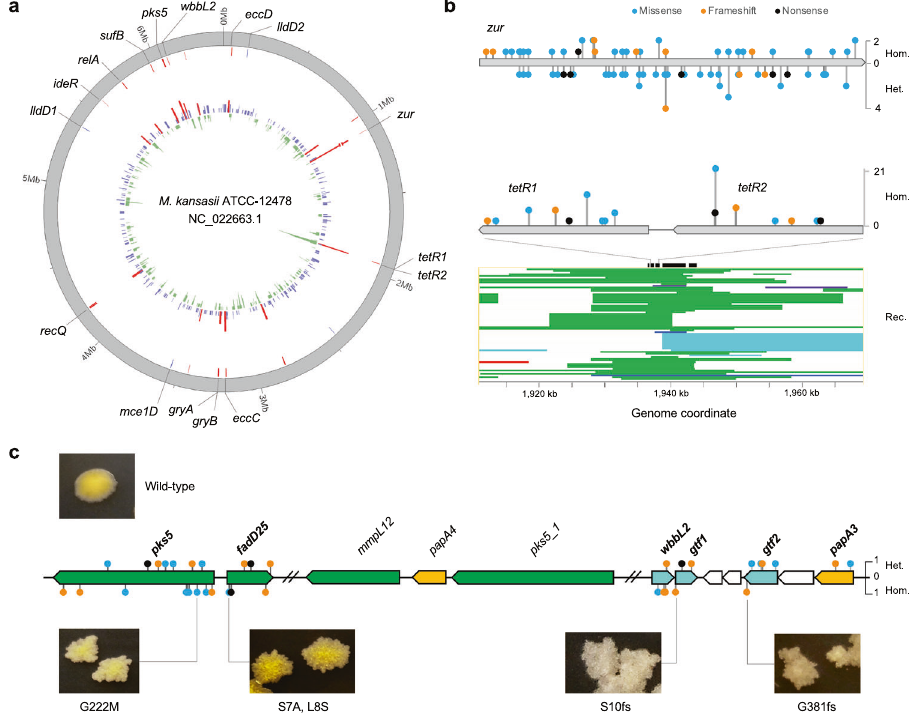
Fig. 5 Genes under positive selections in the MKMC. a Circular plot of genes under potential positive selection. Innermost inward bars, number of recombination per gene; innermost outward bars, number of mutations per gene (red bars, n ≥ 4); outer red lines, location of highly polymorphic genes; outer blue line, location of genes with convergent mutations. b Schematic diagrams depicting the distribution and frequency of non-synonymous mutations in zur and tetR1/2 , and the recombinations around tetR1/2 . Hom. homozygous mutation, Het. heterozygous mutation, Rec. recombination (strip colors represent donor subspecies corresponding to Fig. 2a). Source data are provided as a Source Data fi le. c Schematic representation of mutations in LOS biosynthesis genes and corresponding morphology of the mutant strains. Genes were colored according to their functions. Green, genes involved in polyketide synthesis; orange, acyltransferase; cyan, glucosyltransferase. fs frameshift. Source data are provided as a Source Data fi